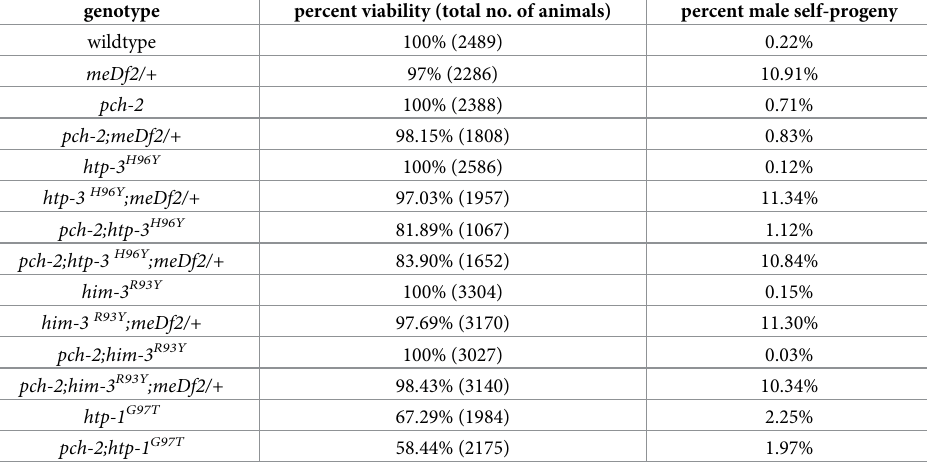
Table 1. Viability and percent male-self-progeny. Table with percent viable progeny and males. Total number of progeny listed in